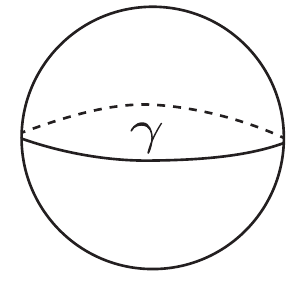
Figure 3 . A sphere S D — drawn here for D = 2 — with a closed geodesic γ , the Euclidean worldline of the